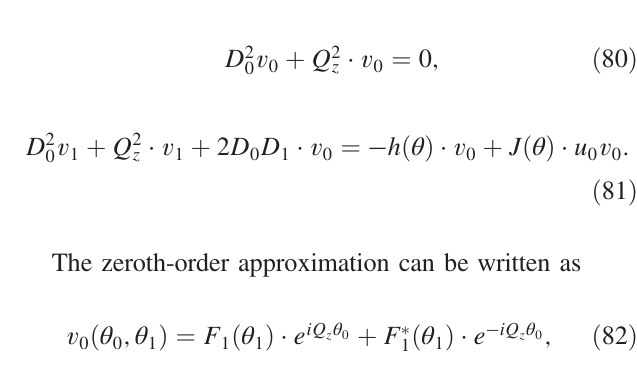
FIG. 5. (Left) Relationship between the perturbed radial tune Q harmonic values. (Right) Radial oscillations obtained by the numerical simulation and analytical